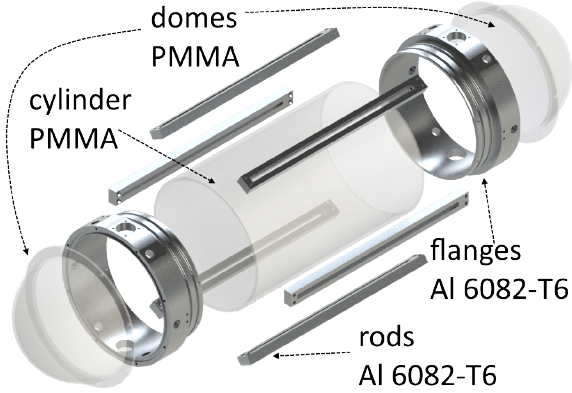
Figure 4. Main mechanical structure of FeelHippo